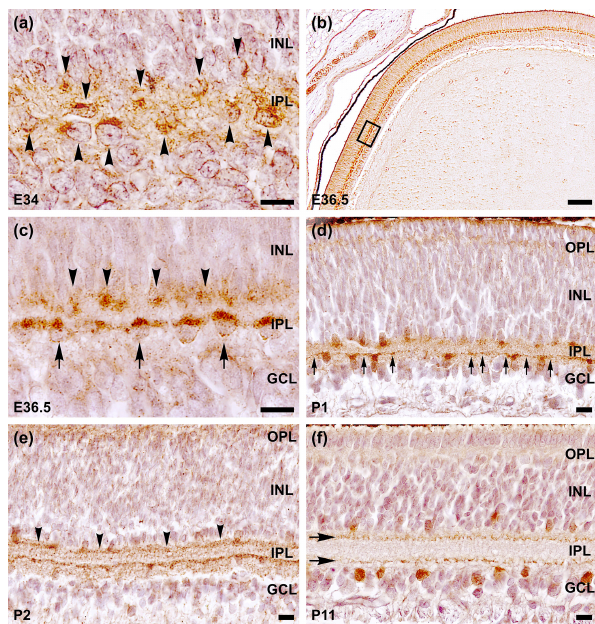
Figure 5. Development of starburst amacrine cells in the retina of Tupaia belangeri . (a) Appearance of anti-choline acetyltransferase (ChAT)-immunopositive precursors (arrowheads) in the developing inner plexiform layer (IPL) on embryonic day (E) 34. ( b , c : detail magnified from boxed area in b ) Segregation of orthotopic (arrow- heads in c ) and displaced starburst amacrines (arrows in c ) on E36.5. (d) Prior to orthotopic amacrines, displaced amacrines start build- ing up their dendritic band (arrows) already on postnatal day (P) 1. (e) Onset of stratification of orthotopic amacrines (arrowheads) on P2. (f) Two starburst amacrine cell strata are present on P11. GCL, ganglion cell layer; INL, inner nuclear layer; OPL, outer plexiform layer. Scale bars = 10µm in (a, c–f) ; 100µm in (b) . Reproduced from Knabe et al. (2007, Fig. 2.) © 2007 Wiley-Liss, Inc., by per- mission of John Wiley & Sons,